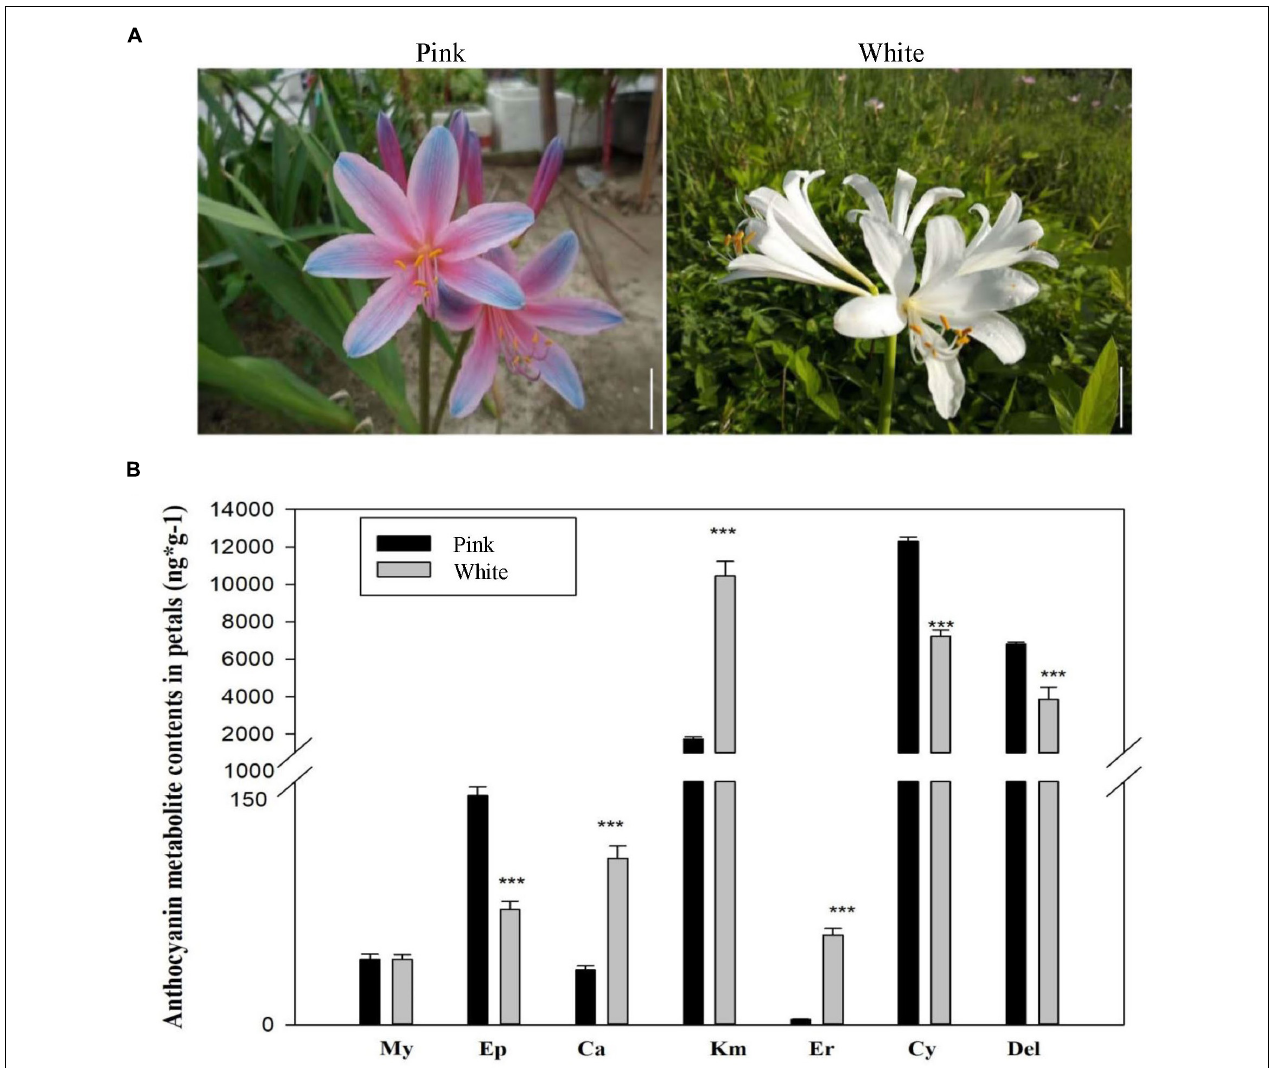
FIGURE 2 | Phenotypic characteristics analysis of pink and white petals in Lycoris sprengeri . (A) Morphological comparison of white and pink petals of L. sprengeri under wild conditions. (B) Liquid chromatographic tandem mass spectrometry (LC-MS/MS) analysis of core metabolites in flavonoid biosynthesis